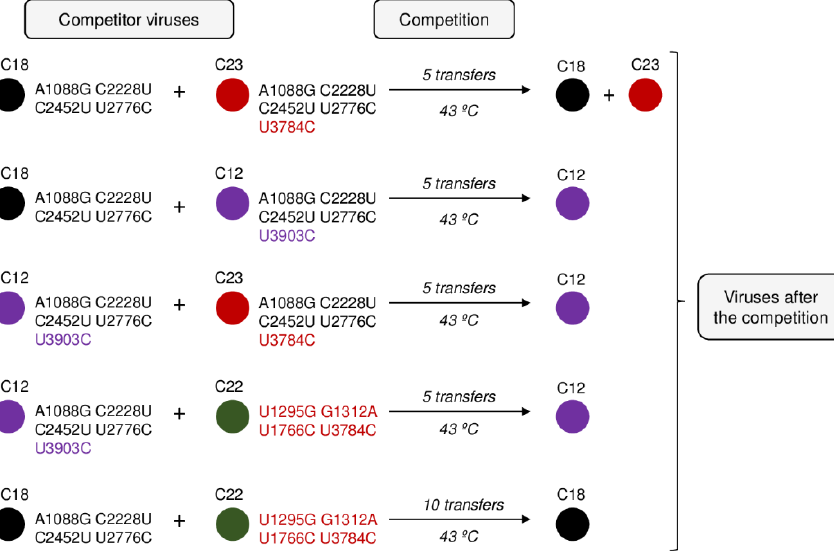
Figure 4. Competitions between pairs of biological clones. All clones were isolated from L1 at transfer 15 (Table 2). Competitions were carried in duplicate as described in Materials and Methods (Section 4). Mutations that were fixed at transfer 25 in L1 are indicated in black, those that remained as polymorphisms at the same transfer are indicated in purple, and those that did not reach fixation or disappeared at later stages are indicated in